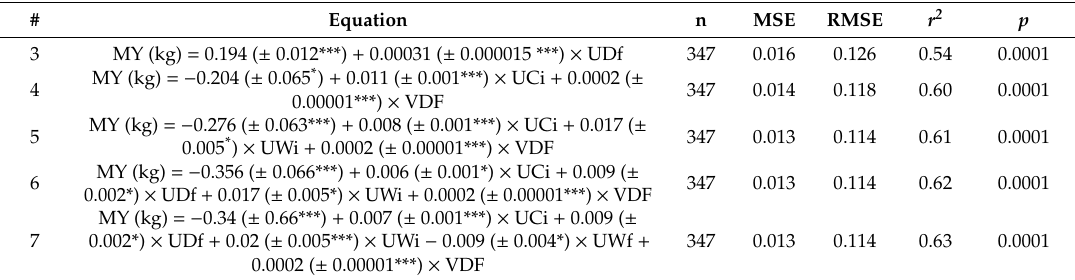
Table 3. Regression equations for predicting milk yield (MY, kg / d) according to udder measurements in Pelibuey ewes.